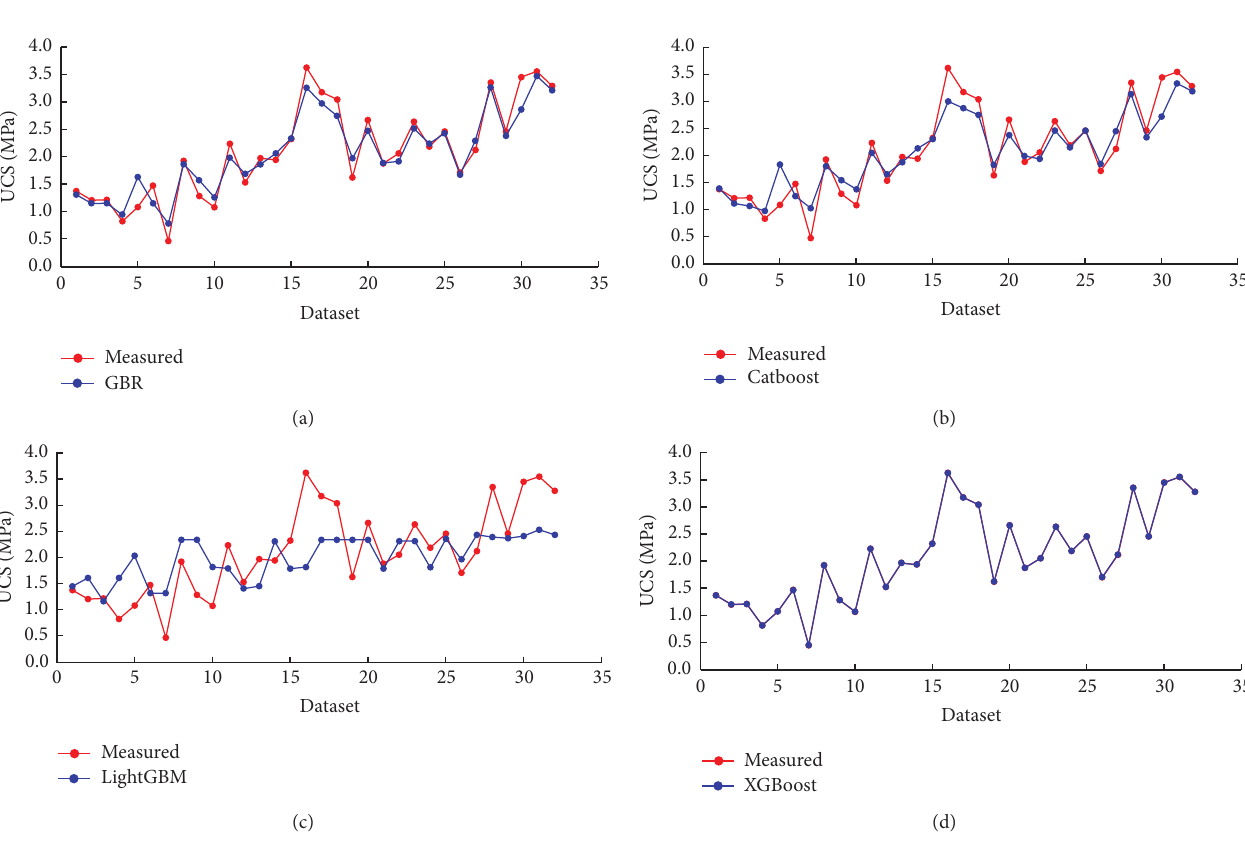
Figure 12: Performance plots of predicted UCS as opposed to measured UCS in the testing stage phase: (a) GBR, (b) Catboost, (c) LightGBM, and (d)